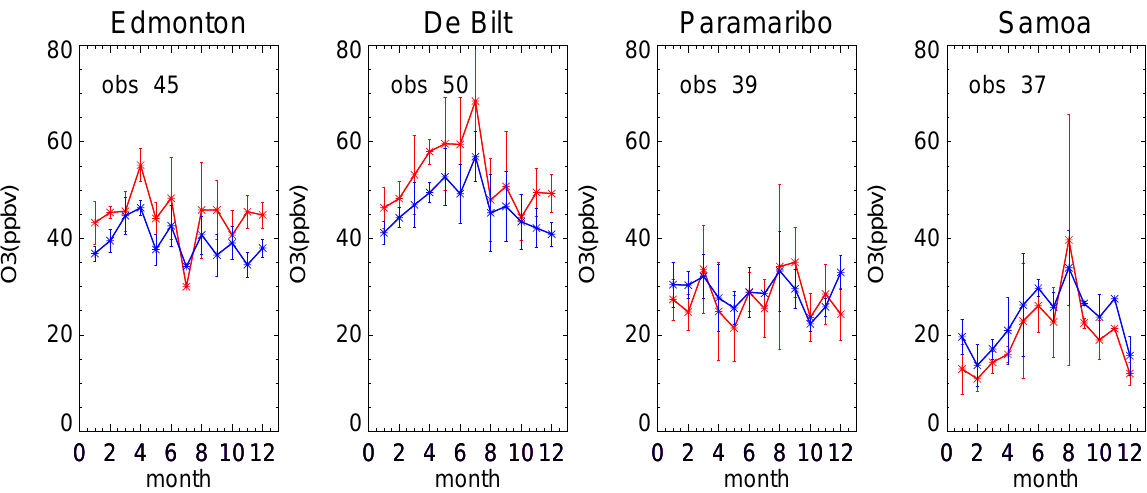
Fig. 15. The annual cycle in the simulated ozone concentrations (blue) in the layers between 800–700hPa compared to WOUDC sonde observations (red) at the stations Edmonton (53.5 ◦ N, 114 ◦ W), De Bilt (52 ◦ N, 5.2 ◦ E), Paramaribo (5.9 ◦ N, 55.2 ◦ W), and Samoa (14 ◦ S, 170.5 ◦ W). Model data is sampled at the time of the observations. The error bars indicate the standard deviation in the monthly